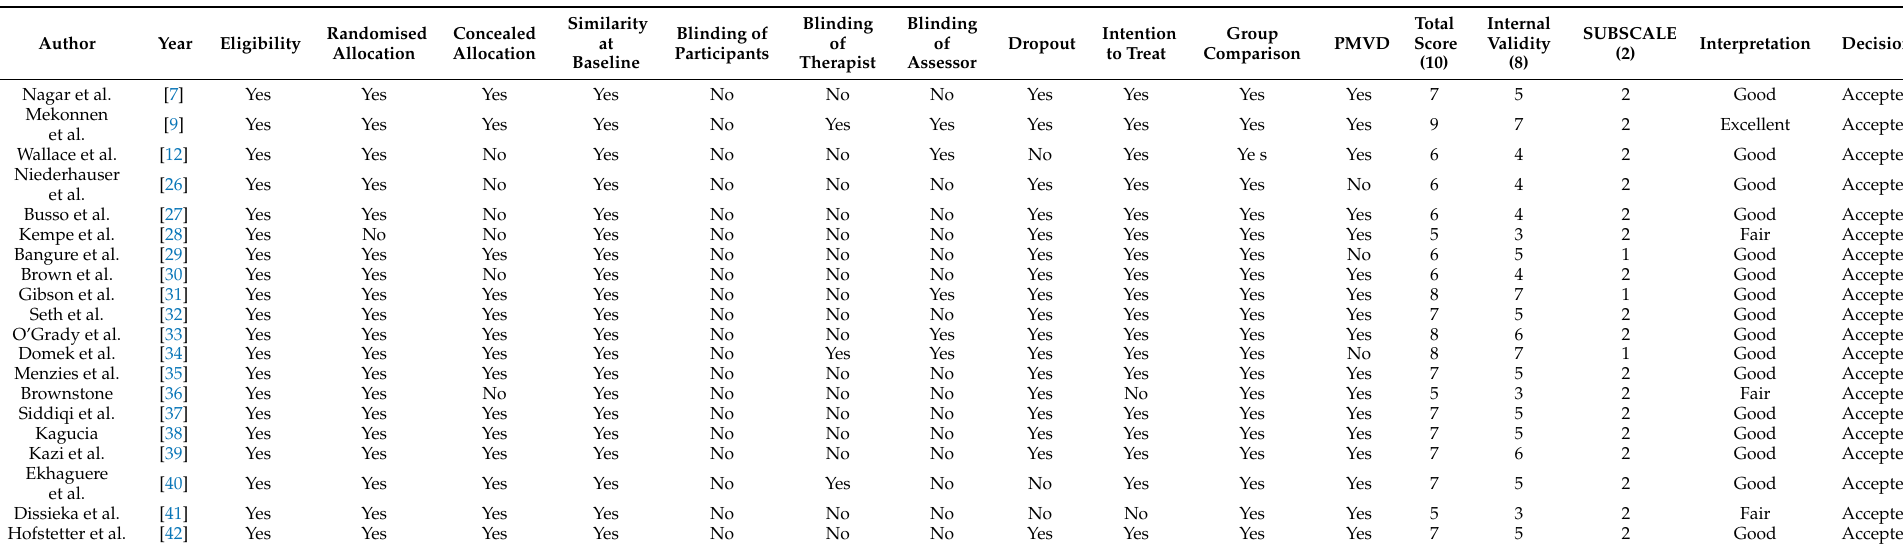
Table 2. Quality appraisal of RCT articles using the PEDro scale.